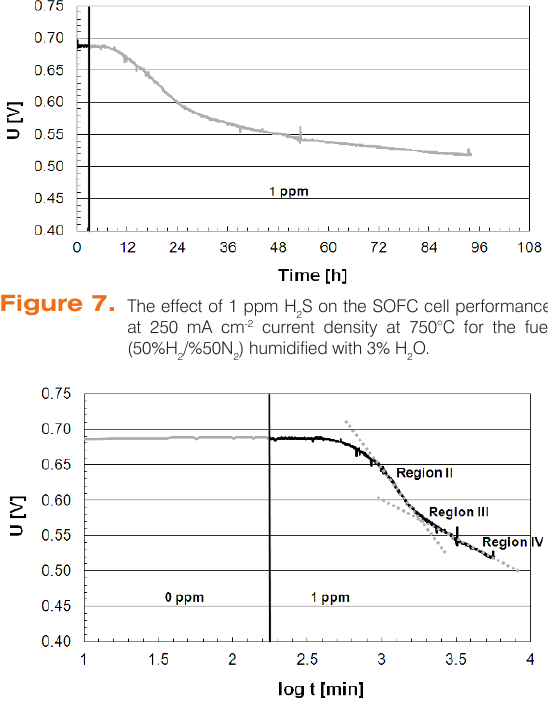
Figure 8. S on the SOFC cell performance The effect of 1 ppm H 2 at 250 mA cm -2 current density at 750°C for the fuel (50%H /%50N ) humidified with 3% H 2 2 logarithmic performance decline